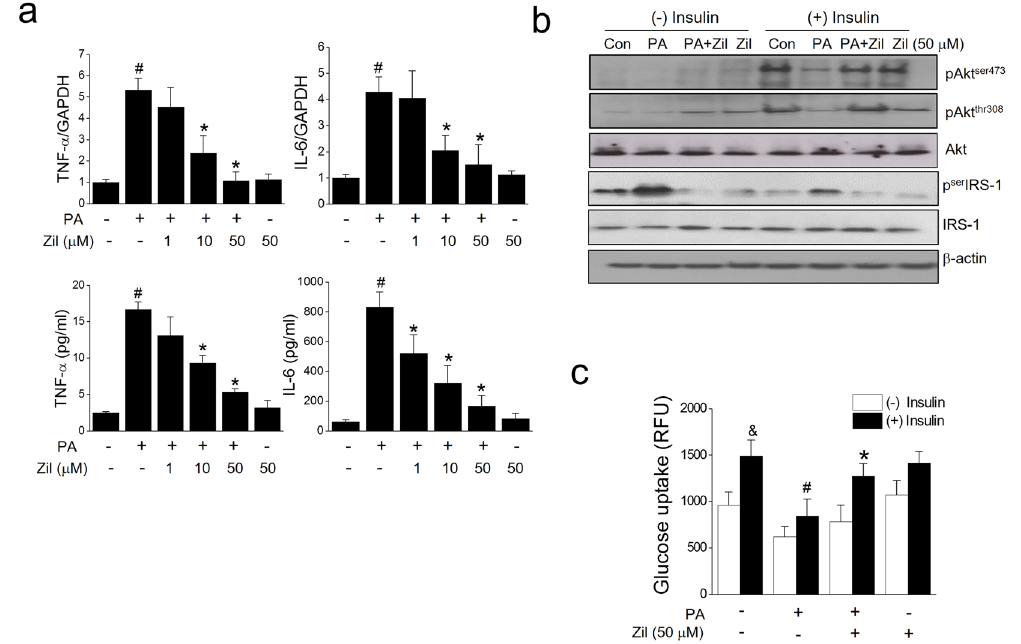
Figure 2. Effects of zileuton on PA-induced inflammation and insulin resistance. Differentiated C2C12 myotubes were exposed to different concentrations of zileuton (1–50 μ M) for 1 h and then treated with PA (750 μ M) in the presence of zileuton for 12 h (qPCR) or 24 h (ELISA). Levels of pro-inflammatory cytokines were determined by ELISA and qPCR ( a ). After 24 h of PA treatment, insulin (1 μ g/ml) was added for 30 min, and then insulin signaling, as indicated by Akt and serIRS-1 phosphorylation, was assessed by western blotting ( b ). Glucose uptake was determined by 2-NBDG ( c ). The results of the western blotting are shown as the representative of three independent experiments ( b ), and other results are expressed as the means ± SDs of three experiments performed in triplicate. # P < 0.05 vs . non-treated controls, * P < 0.05 vs . PA alone, & P < 0.05 vs . ( − )